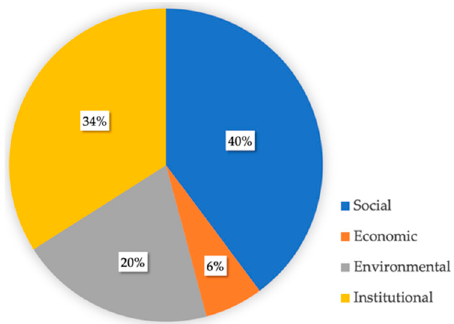
Figure 5. Breakdown of actions by sustainability dimension (Source: author).